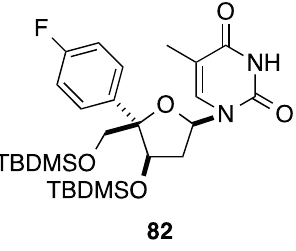
Figure 4. 5( R )-(4-Fluorophenyl)tetrahydrofuran derivative 82